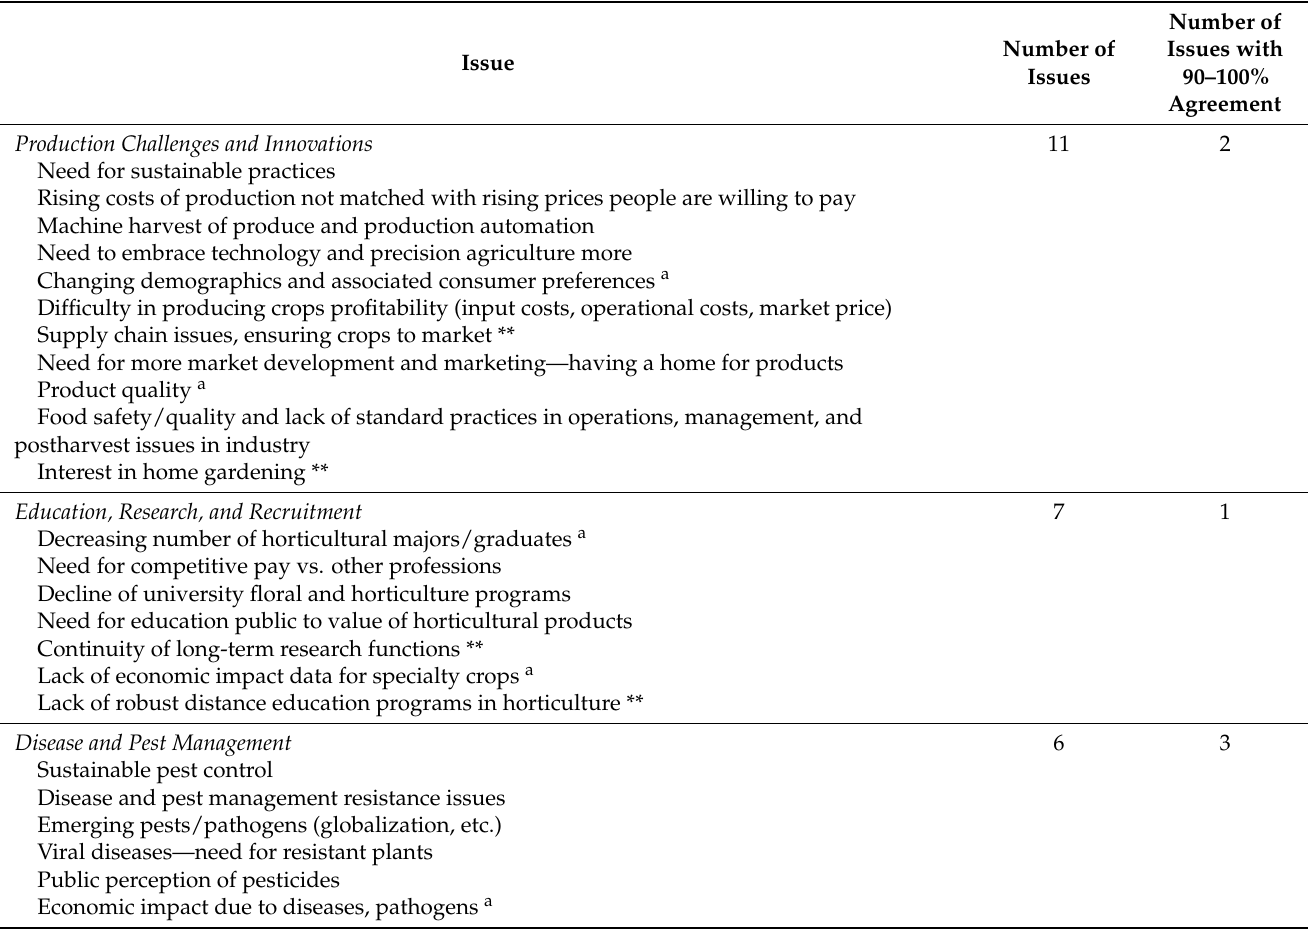
Table 4. Constant Comparative Method Thematic Analysis Results ( n =